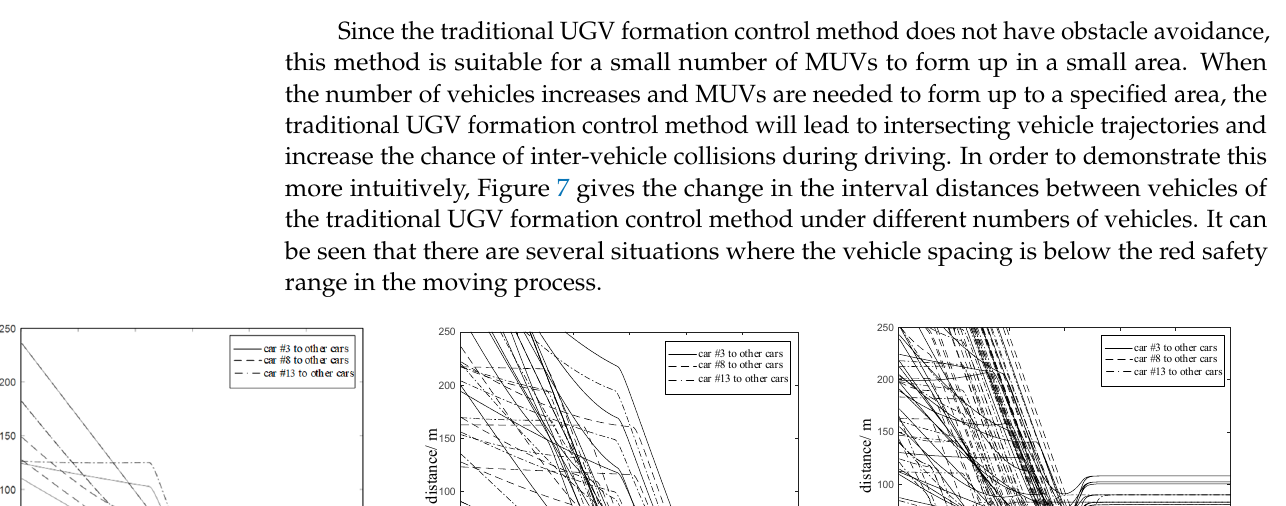
Figure 6. Path results of the traditional UGV formation control method. ( a – c ) represent the path results for 5, 15, and 30 vehicles, respectively.